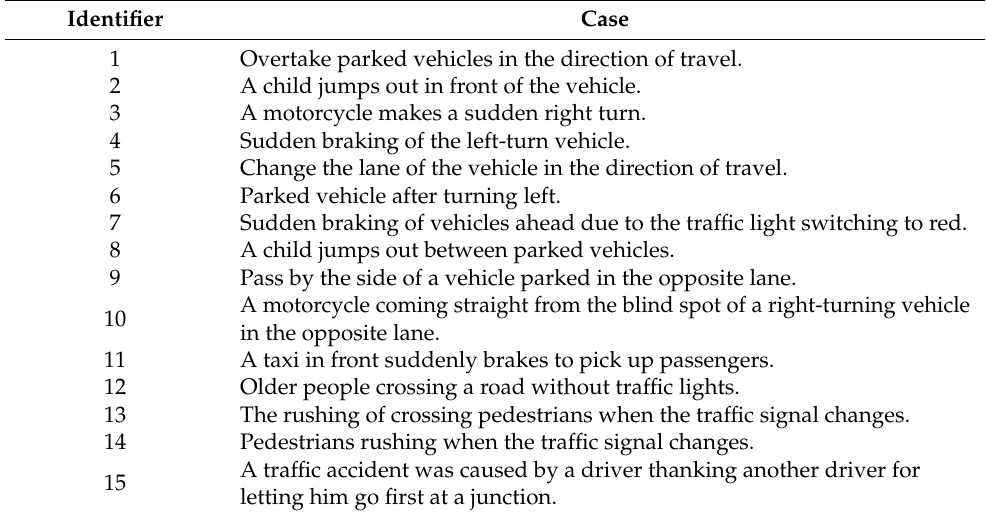
Table 1. Cases where collision accidents are included in the driving route are likely to